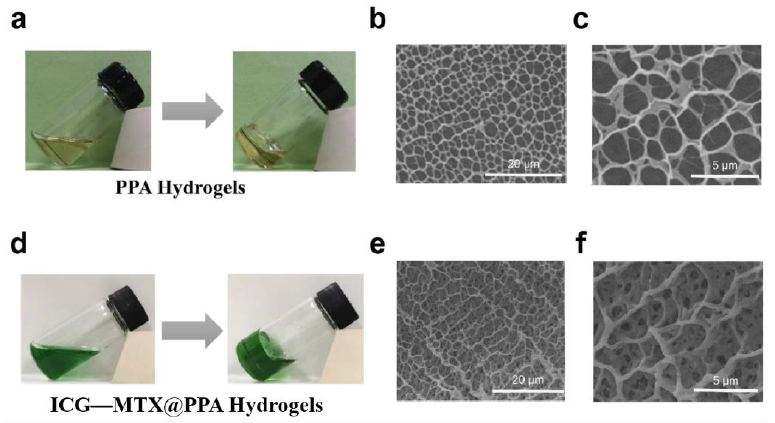
Figure 6. ( a ) The sol – gel transition of PPA Gels at 45 °C and its SEM image ( b , c ). ( d ) The sol –